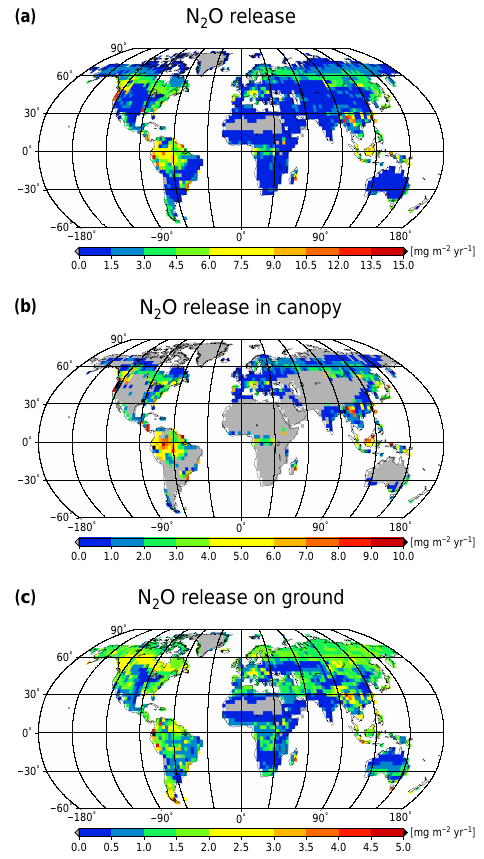
Figure 3. Global patterns of N 2 O release. Nitrous oxide emissions by lichens and bryophytes estimated by LiBry for (a) all locations of growth, (b) the canopy and (c) the ground. Note the differing ranges of the colour bars. Grey colour denotes regions where no simulated species is able to survive, such as ice shields and the driest regions of